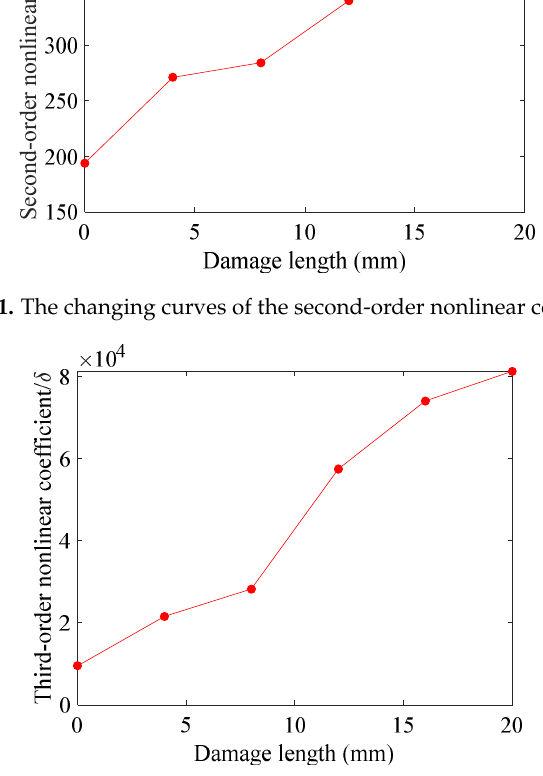
Figure 12. The changing curves of the third-order nonlinear coefficient.